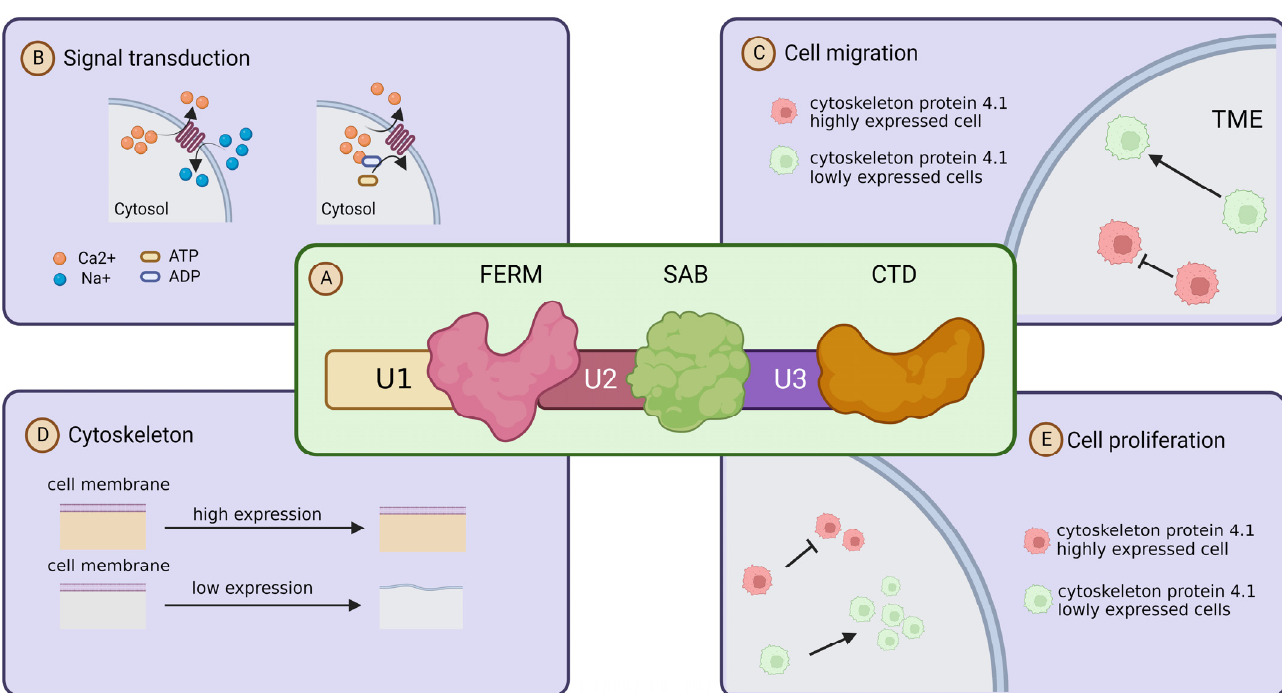
Figure 2. Structure and function of cytoskeleton protein 4.1. ( A ) Schematic diagram of the primary structure of cytoskeleton protein 4.1: Cytoskeleton protein 4.1 family members are composed of three conserved domains (FERM, SABD, CTD) and three unique domains (U1, U2, U3). Their location structure diagram is shown in the illustration. ( B ) Cytoskeleton protein 4.1 and signaling transduction: Cytoskeleton protein 4.1 affects signal transduction by influencing ion transport. ( C ) Cytoskeleton protein 4.1 and cell migration: high expression of cytoskeleton protein 4.1 promotes cell migration. ( D ) Cytoskeleton protein 4.1 and cell membrane stability: high expression of cytoskeleton protein 4.1 maintains the stability of the cell membrane. ( E ) cytoskeleton protein 4.1 and proliferation: high expression of cytoskeleton protein 4.1 inhibits the cell proliferation.